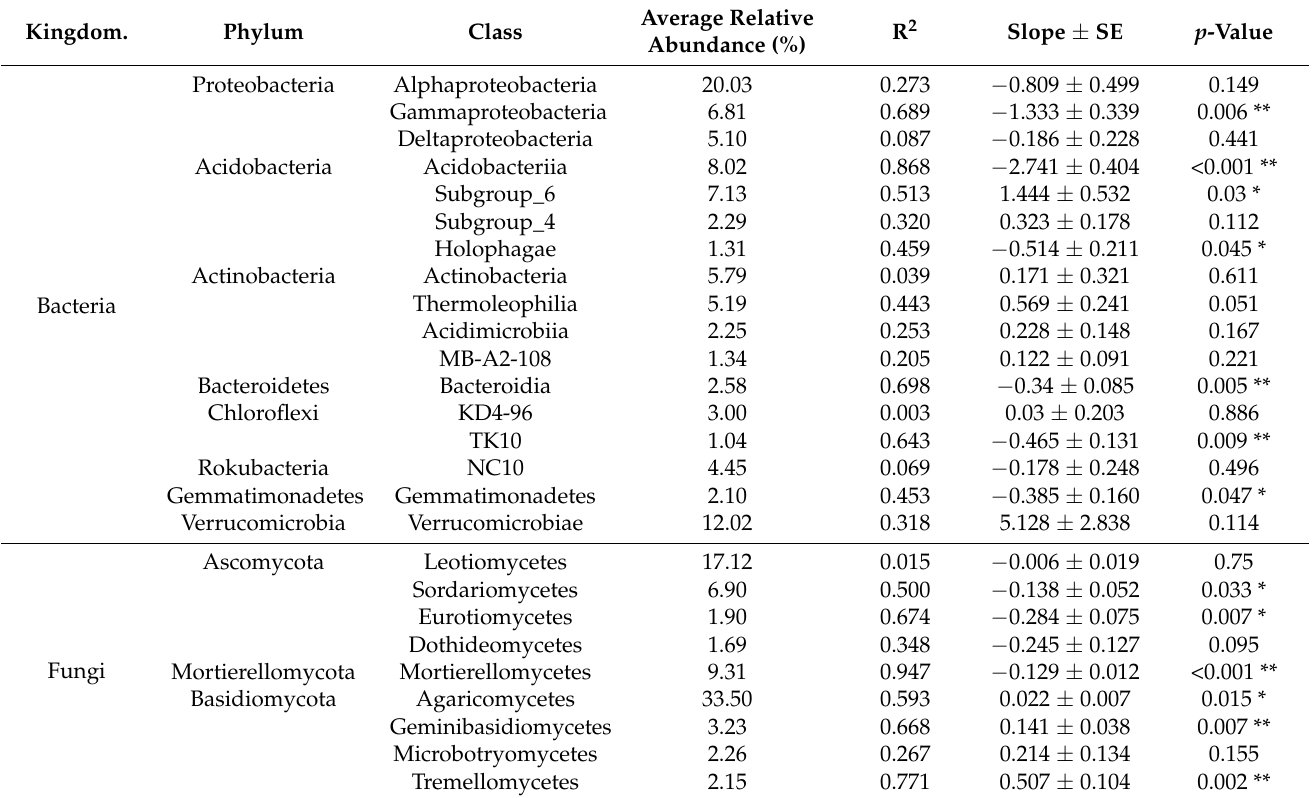
Table A1. Based on the general linear model, the changes of bacterial and fungal class-level commu- nities in broad-leaved Korean pine forest at different succession stages in Lesser Hinggan Mountains.